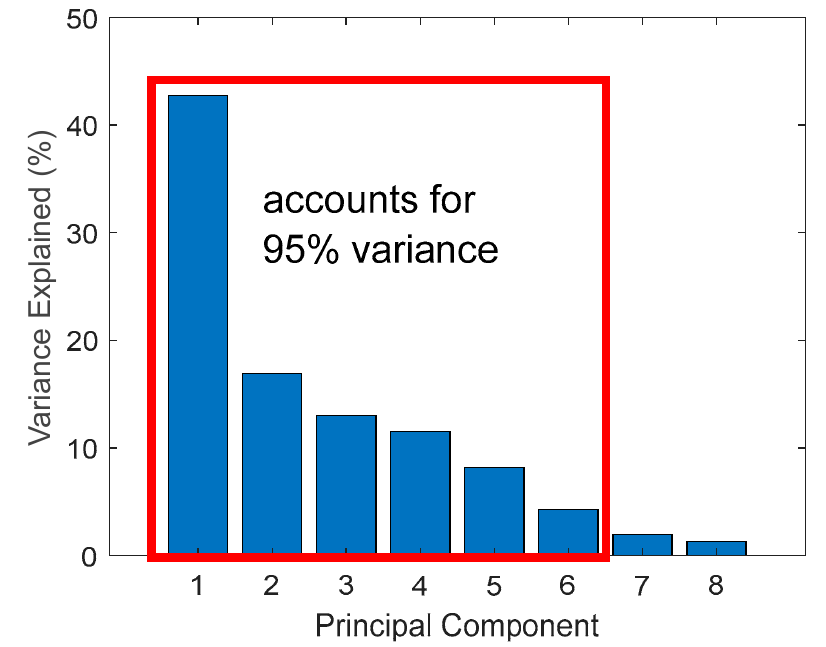
Figure 11. Principal component analysis output.